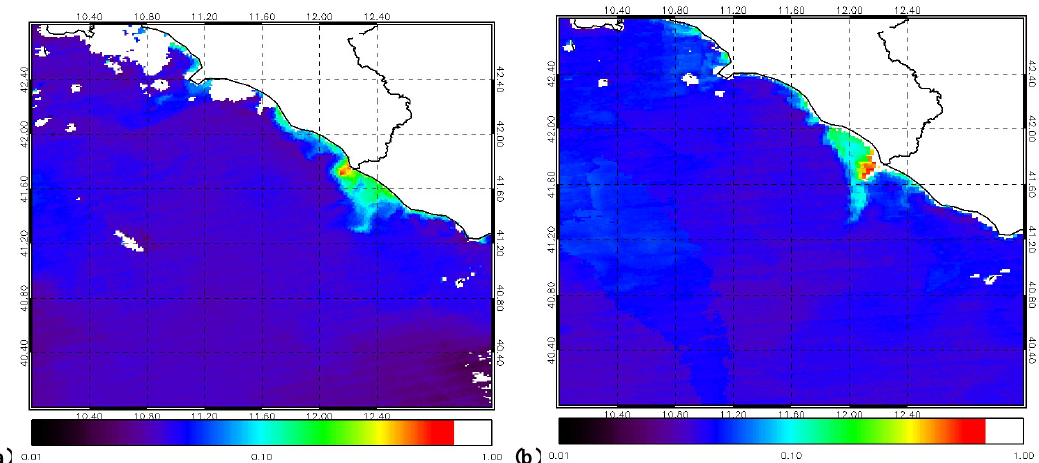
Fig. 12a. 27 July 2010, salinity at –5 m. (a) (b) Fig. 11. (a) 27 July 2010, map of K490; units (m − 1 ), logarithmic scale. (b) 2 August 2010, map of K490; units (m − 1 ), logarithmic scale. 36 Fig. 11b. 2 August 2010, map of K490 ; units ( m − 1 ), logarithmic scale. Fig. 11a. 27 July 2010,map of K490; units ( m − 1 ), logarithmic scale.